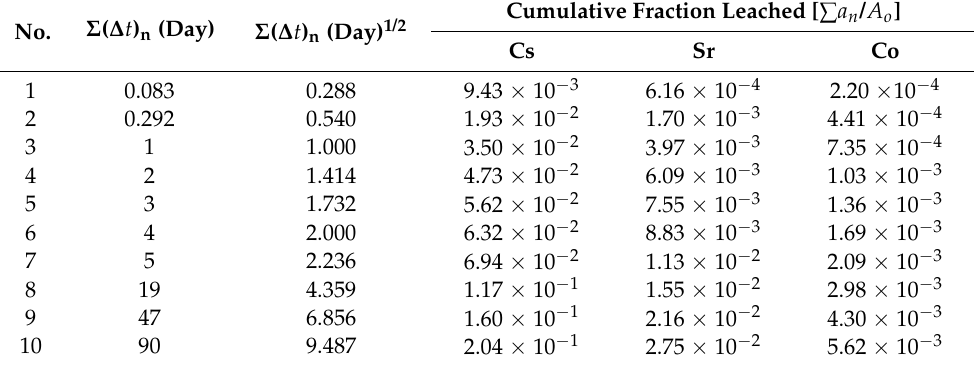
Table 10. Cumulative fraction leached of each nuclide (Cs, Sr, and Co) measured from the cement waste